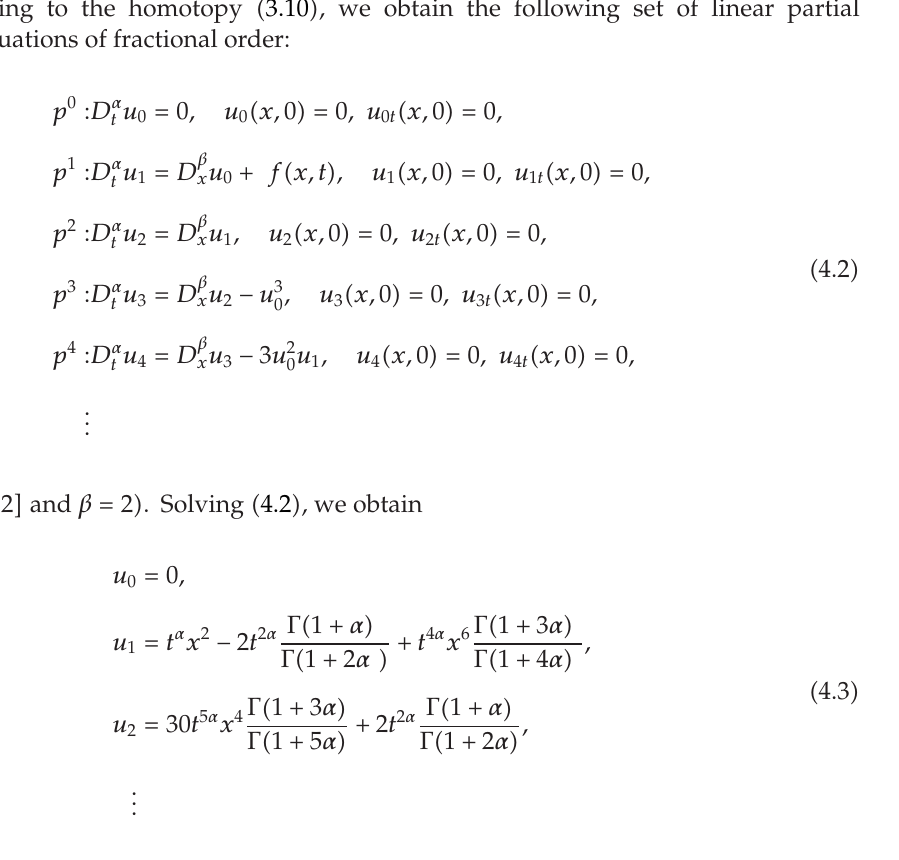
Figure 1 gives the comparison between the HPM 6th-order approximate solution of problem (cid:2) 4.1 (cid:3) in Case 1 with β (cid:9) 2 , α (cid:9) 1 . 99 , 1 . 95 , 1 . 90, and 1.85 and the solution of corresponding problem of integer order denoted by u 2 , 2 at t (cid:9) 0 . 5.